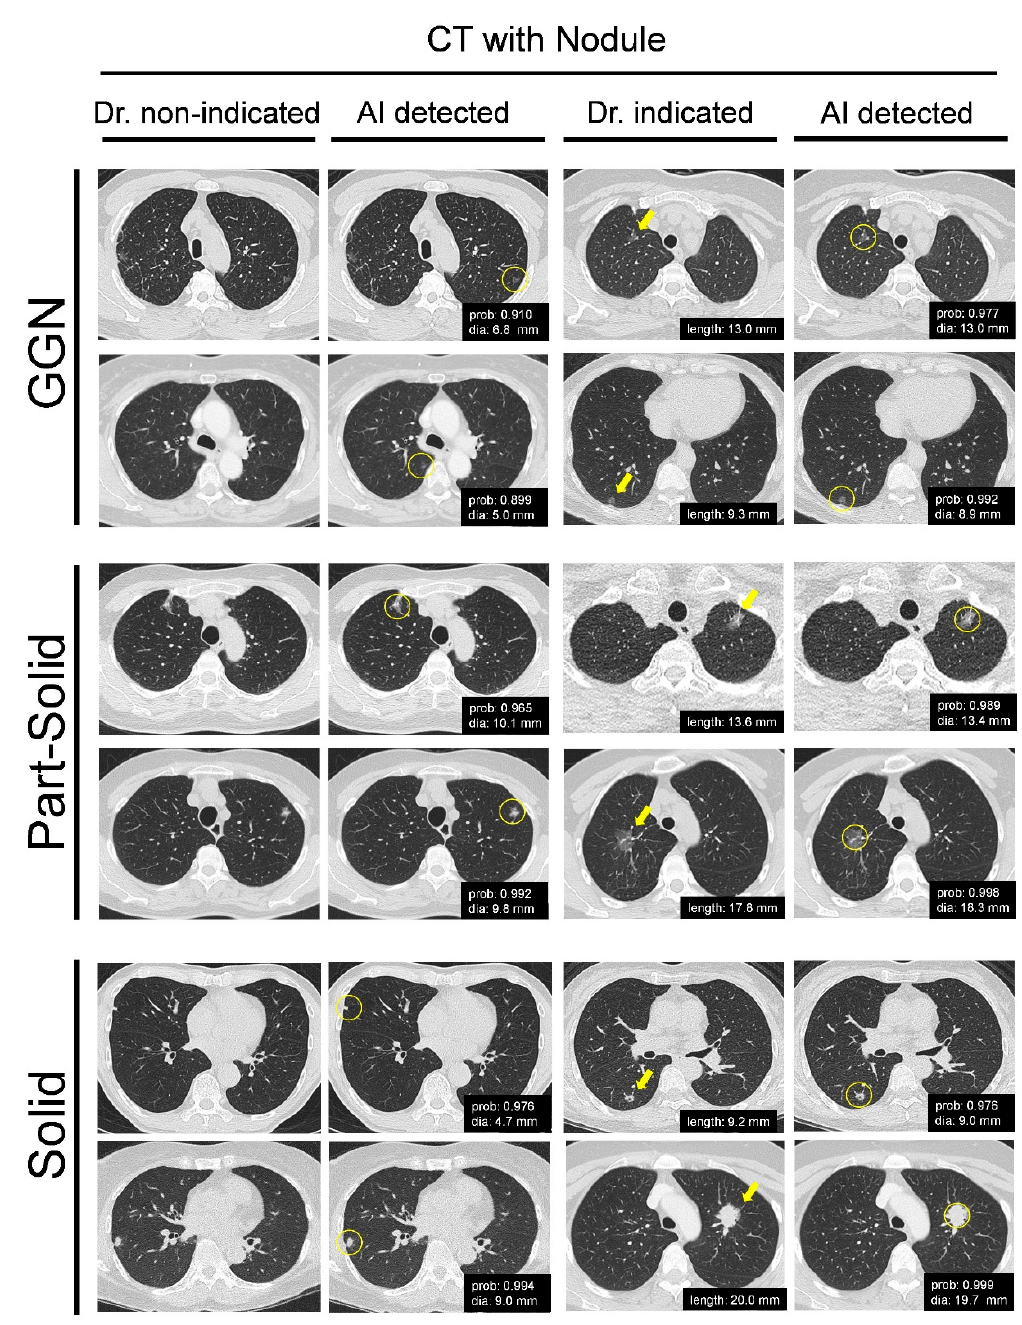
Figure 3. Comparison of the lung nodules detected by doctors with or without AI assistance. Multi-type lung nodules, including GGN, part-solid, and solid, were detected by the doctors with or without AI assistance in advance, and the paired CT images with discrepancies between AI engagement and doctor-alone examination were selected for comparison. The two left columns show that the slices annotated by AI software but not indicated by doctors. The two right columns show the slices simultaneously annotated by AI software and indicated by doctors. The representative images show the paired CT images in the same slice number. The yellow circles indicate pulmonary nodules detected by AI. The yellow arrows indicate pulmonary nodules found by physicians. AI, artificial intelligence; CT, computed tomography; GGN, ground glass nodules.